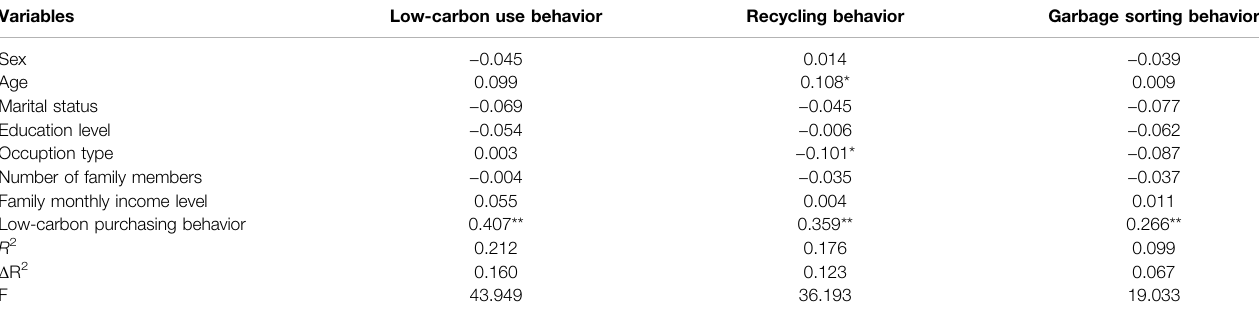
TABLE 4 | Direct effect analysis.